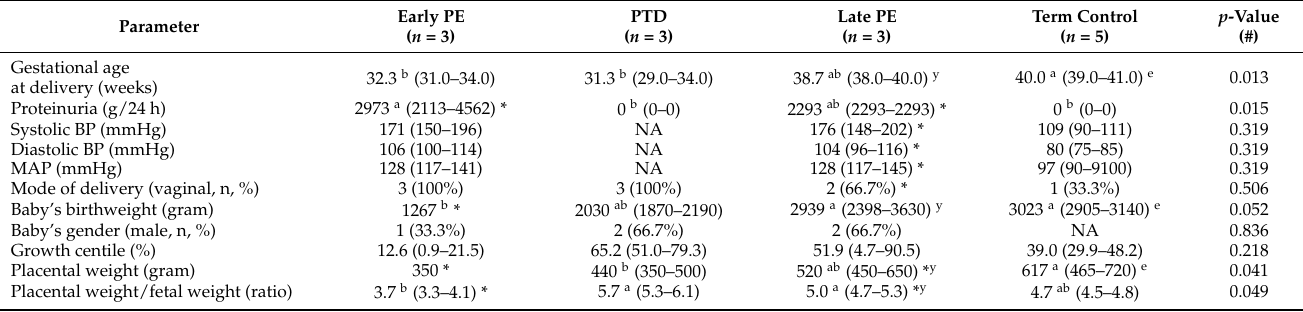
Table 3. Demographic and pregnancy characterization—Austrian